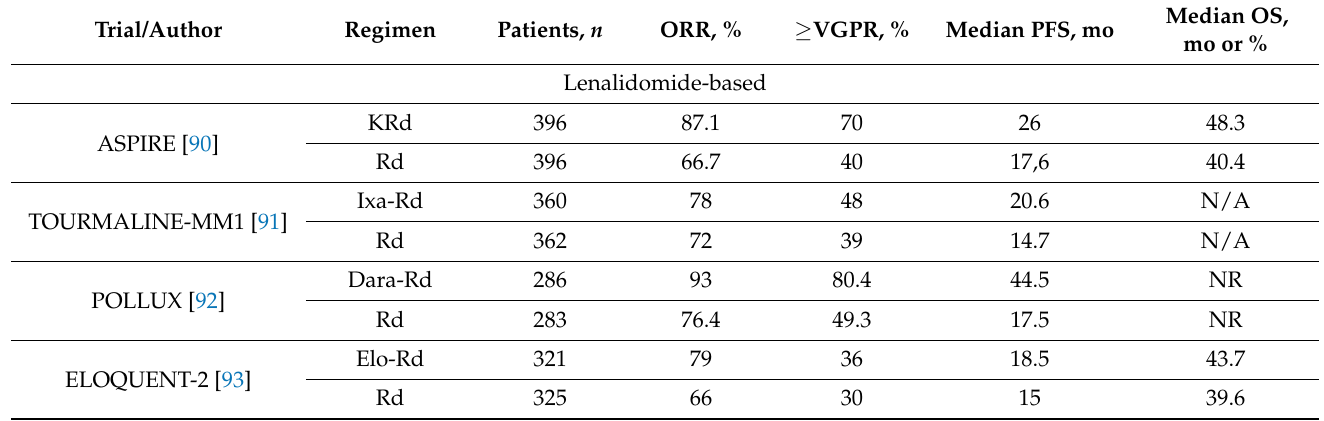
Table 2. Results of randomized studies in relapsed/refractory multiple